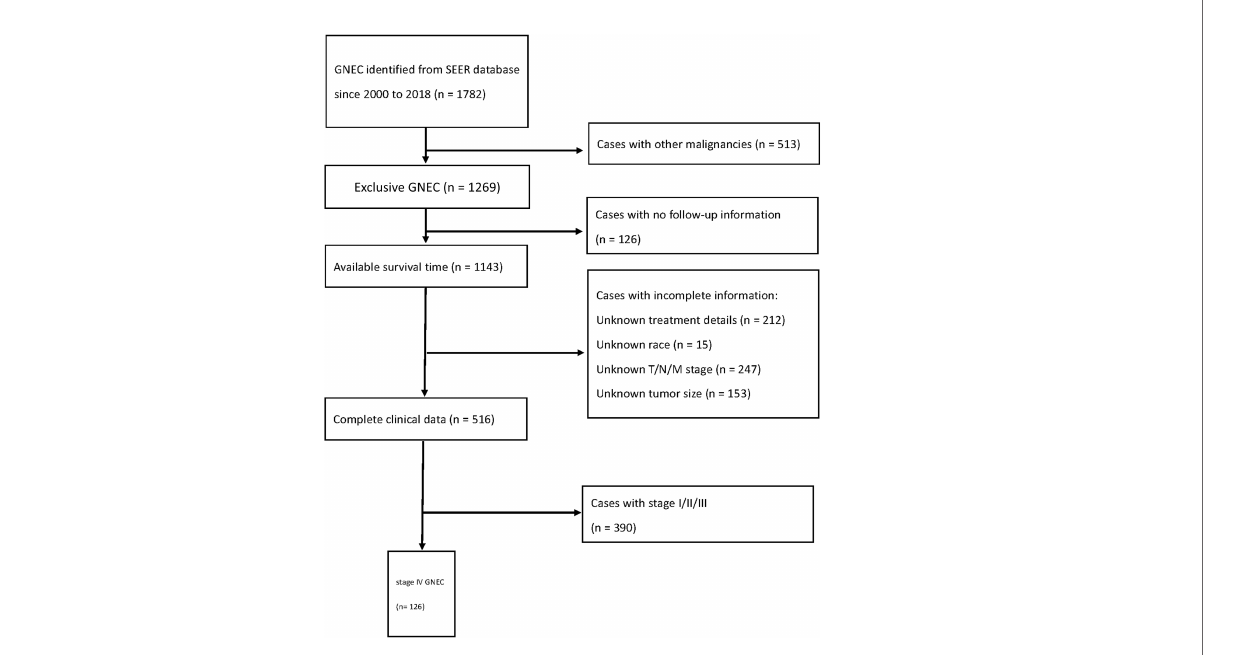
FIGURE 1 | Schematic overview for patients identi fi